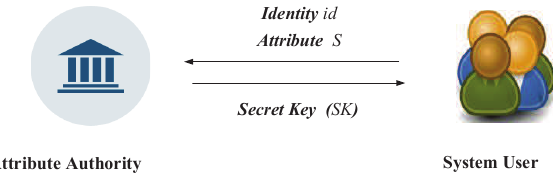
Figure 3. User registration.